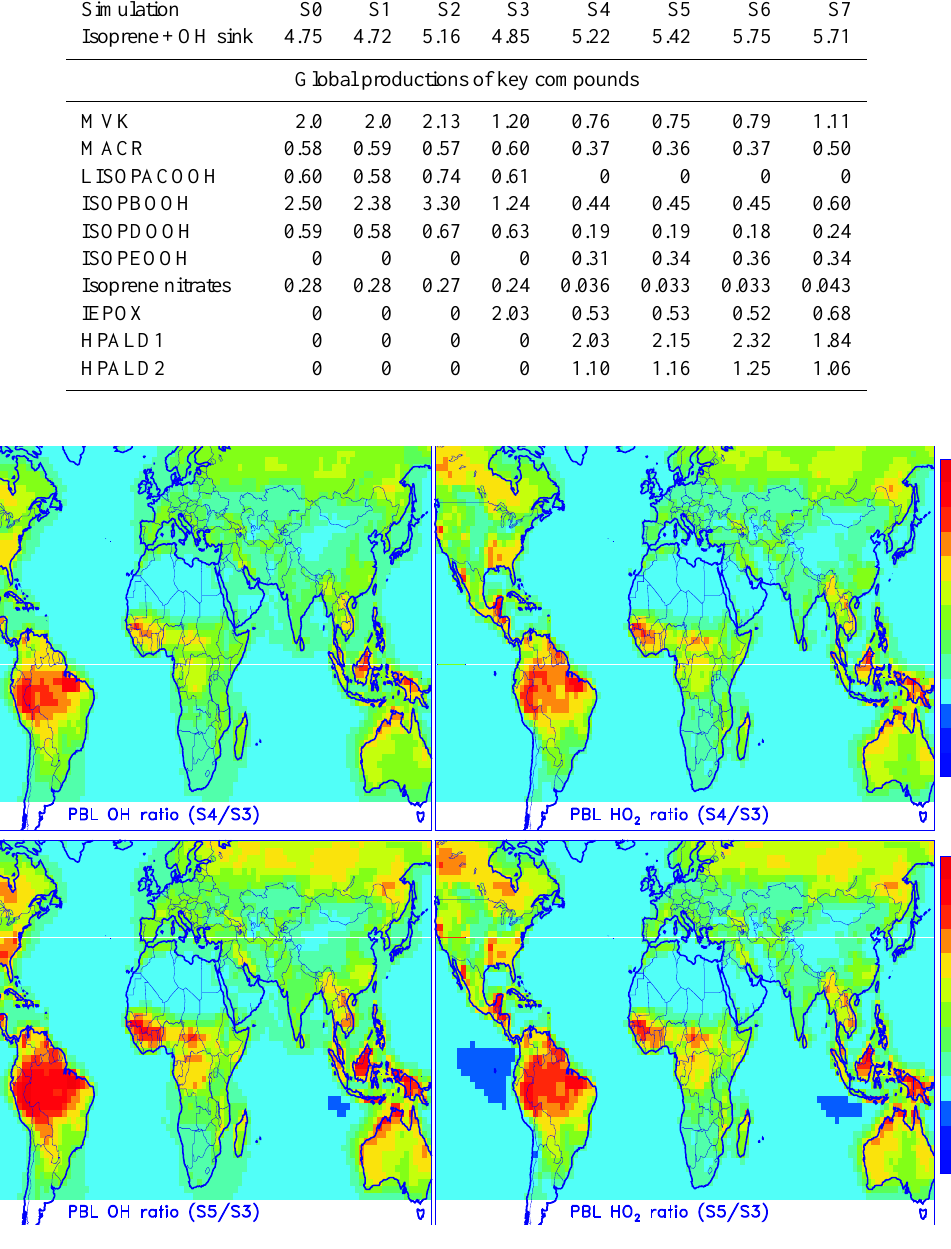
Fig. 4. Calculated impact on OH (left) and HO 2 (right) concentrations (July 2005, below 1.5km) of the LIM0 mechanism update (Peeters et al., 2009; Peeters and M¨uller, 2010) with m = 1 (upper panels), and m = 3 (lower